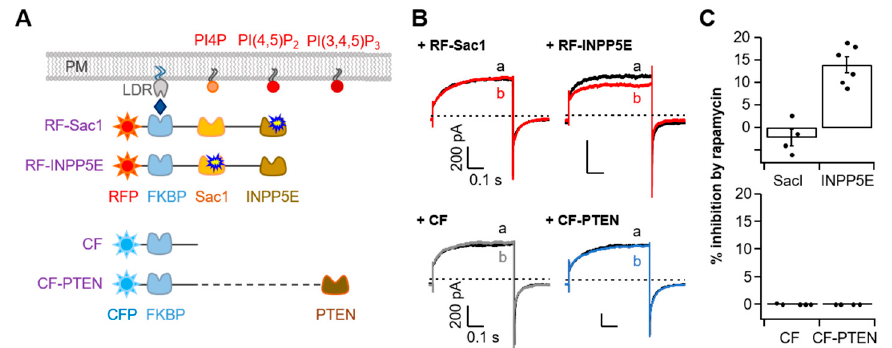
Figure 4. Specific TMEM16A current inhibition via the depletion of PI(4,5)P 2 but not PI4P or PI(3,4,5)P 3 . ( A ) Strategy used to dephosphorylate PI4P, PI(4,5)P 2 , or PI(3,4,5)P 3 using a rapamycin-induced dimerization system. RF-Sac1, 4-phospha- tase; RF-INPP5E, 5-phosphatase; CF-PTEN, PI(3,4,5)P 3 phosphatase. CF was constructed without a phosphatase enzyme. ( B ) Representative currents before (black trace) and after (colored trace) the addition of rapamycin (1 μ M) for 1 min in control cells co-expressing RF-Sac1, RF-INPP5E, CF, or CF-PTEN. ( C ) Summary of inhibition (%) in ( B ) by rapamycin- induced translocation of RF-Sac1, RF-INPP5E, CF, or CF-PTEN to the plasma membrane for TMEM16A(ac). Top: RF-Sac1, n = 4; RF-INPP5E, n = 7. Bottom: CF, n = 4; CF-PTEN, n = 4. Dots indicate the individual data points for each cell. Bars indicate means ±